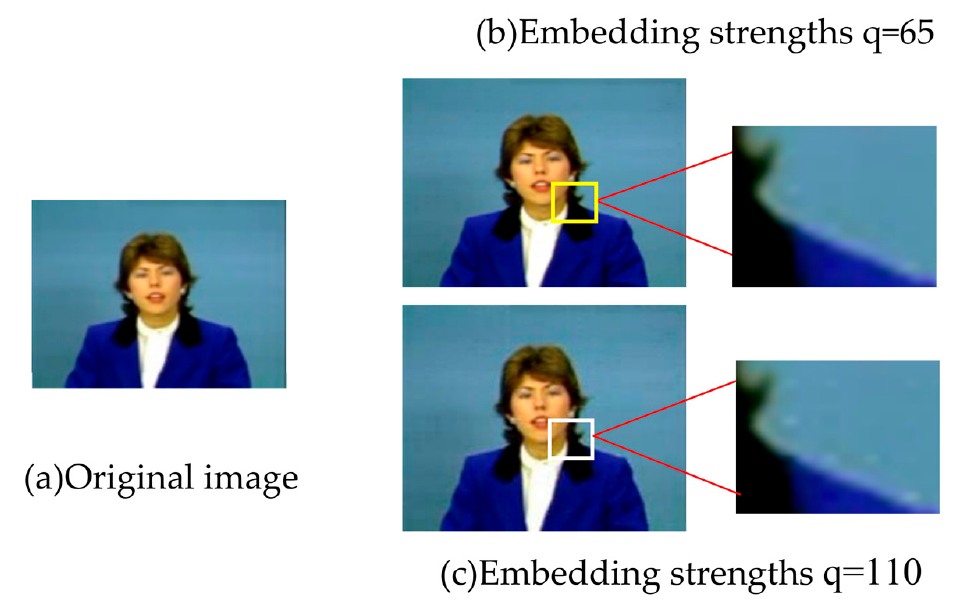
Figure 5. Video images under different embedding strengths.